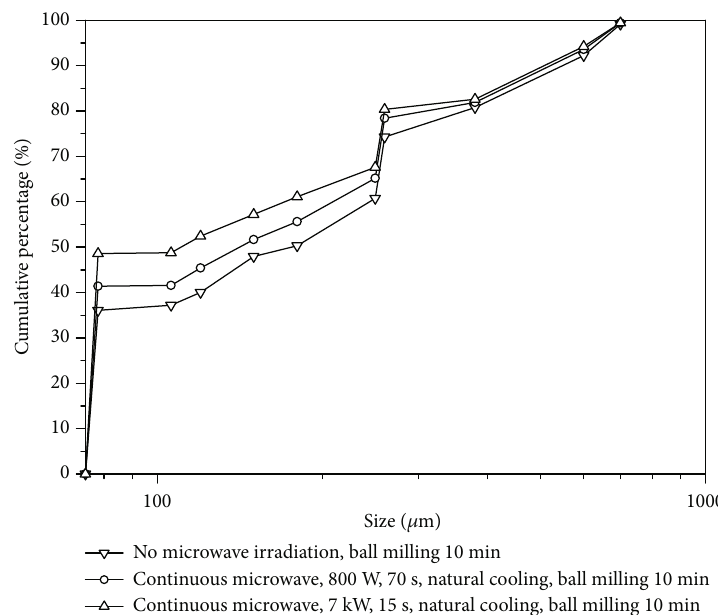
Figure 5: E ff ect of continuous microwave pretreatment on the particle size cumulative percentage of grinding products for lead-zinc